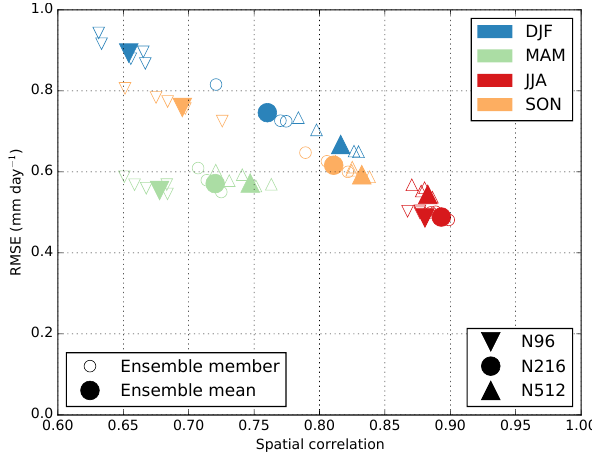
Figure 2. Root-mean-square error (RMSE) and spatial correlation between HadGEM3-GA3 precipitation and E-OBS observations in Europe ( − 14–50 ◦ E, 38–70 ◦ N). The domain-mean bias is dis- carded before calculating the RMSE.